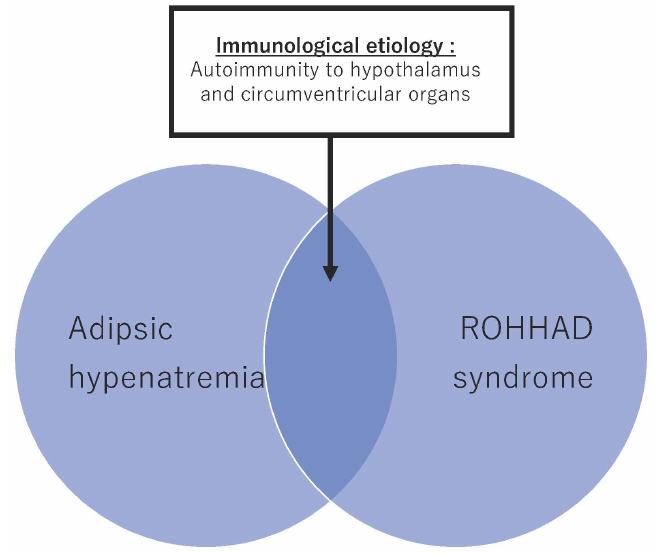
Figure 1. Concept of autoimmunological adipsic hypernatremia and ROHHAD